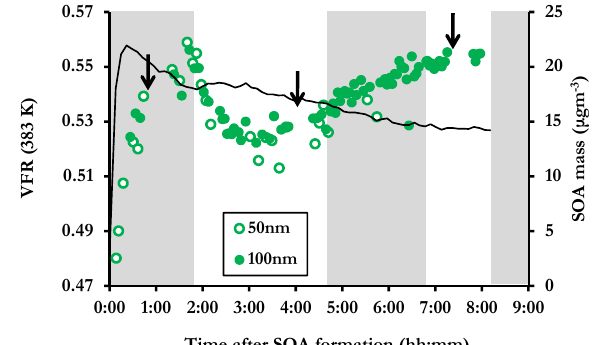
Fig. 1. The change in VFR (383K) with time during experiment SOA08-12 (limonene) in AIDA, white areas indicate ageing with OH radicals (TME addition) and the black arrows when. thermo- grams were started. The black solid line is the SOA mass present in AIDA as measured with